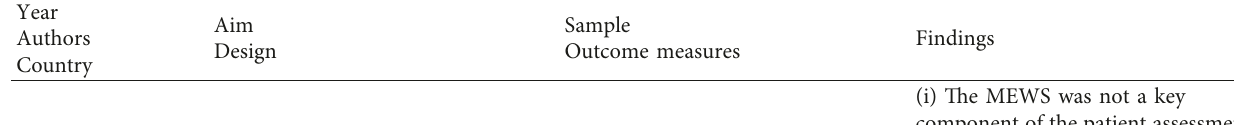
Table 2: Summary of relevant studies on recognizing deteriorating